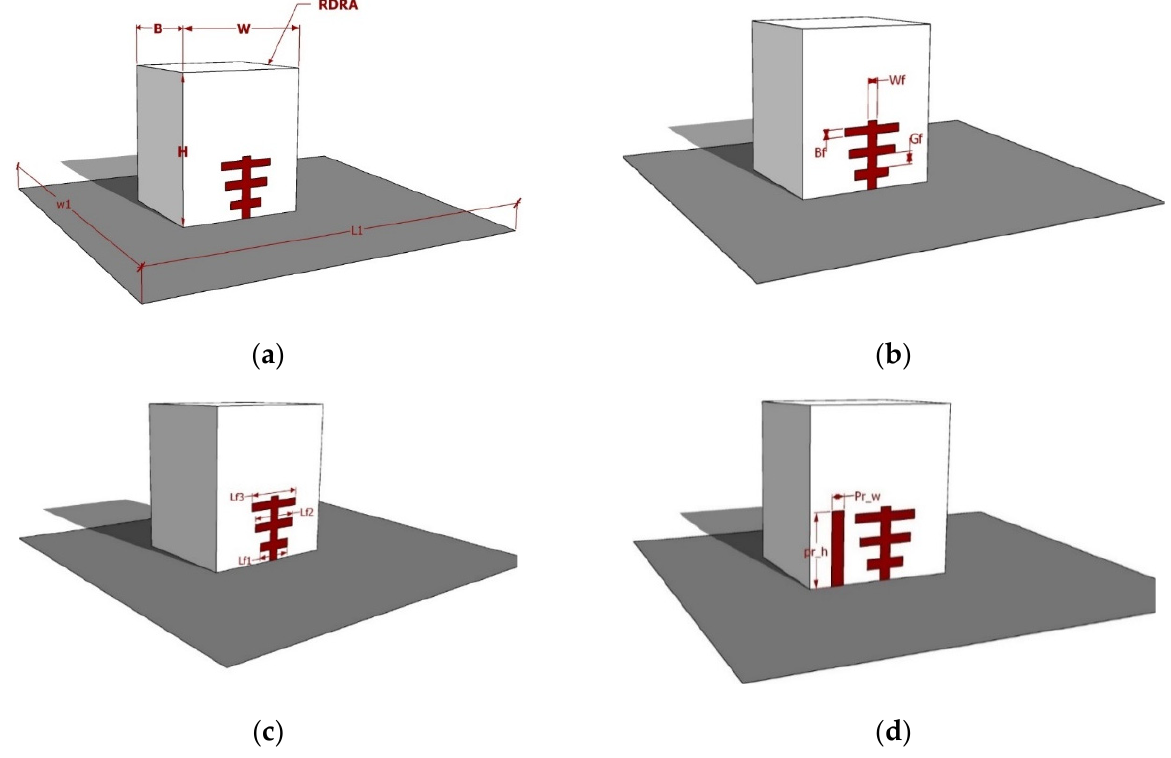
Figure 2. Dimension of the Proposed Yagi ‐ Uda RDRA antenna: ( a ) Dimension of the RDRA; ( b – d ) dimension of the Yagi ‐ Uda Feed structure and parasitic element.